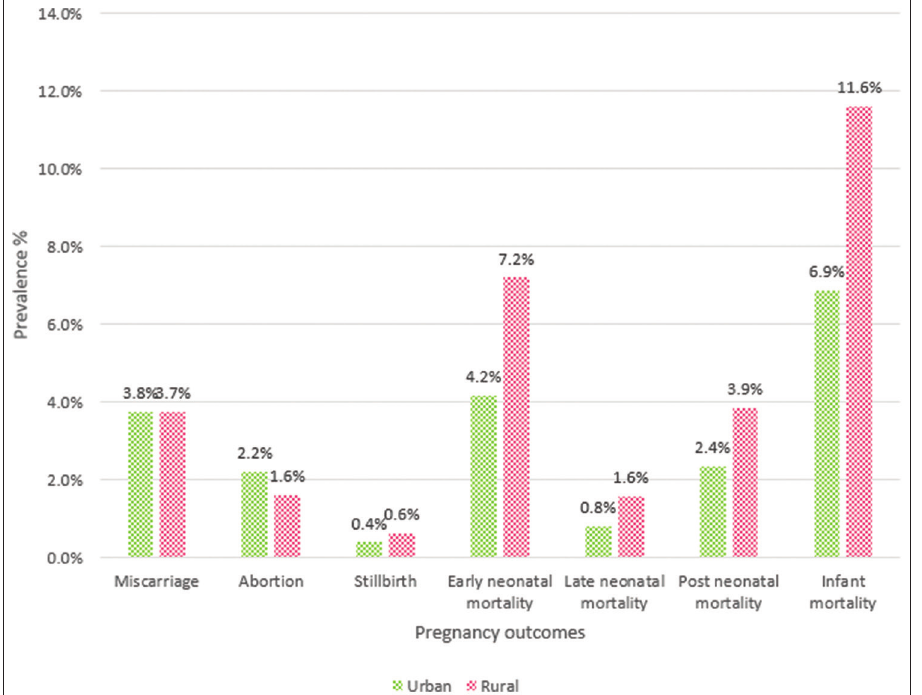
Figure 1: Prevalence of various pregnancy and birth outcomes among urban and rural Indian